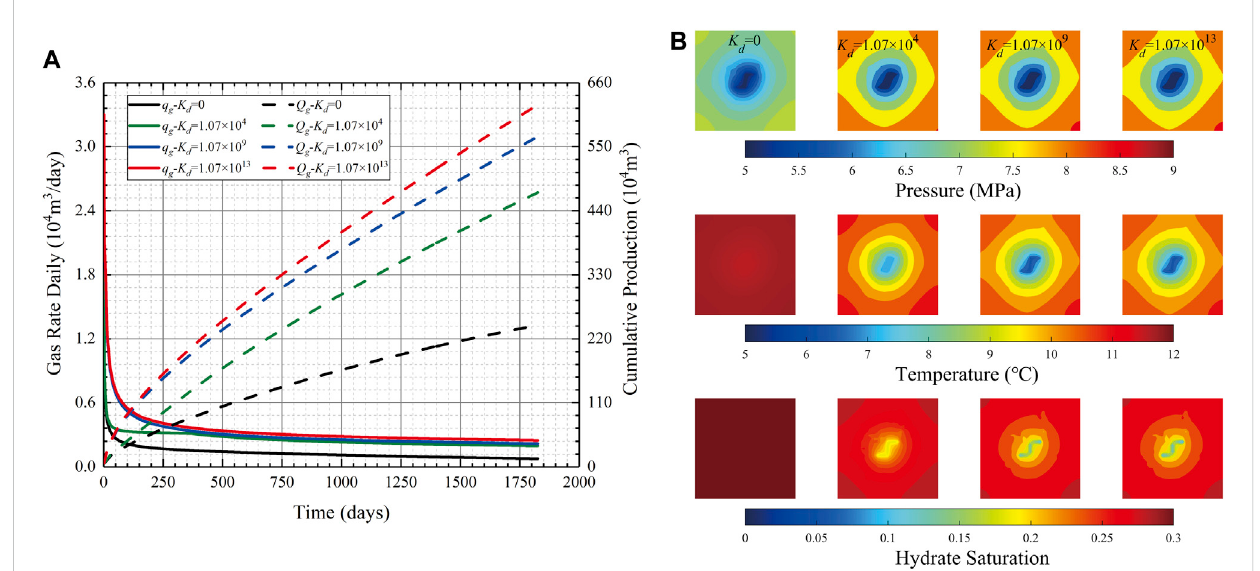
FIGURE 11 Simulation outputs of different scenarios with different values of K d : (A) comparison of the production rates (B) pressure, temperature, and hydrate saturation fi eld maps at the 1800th production